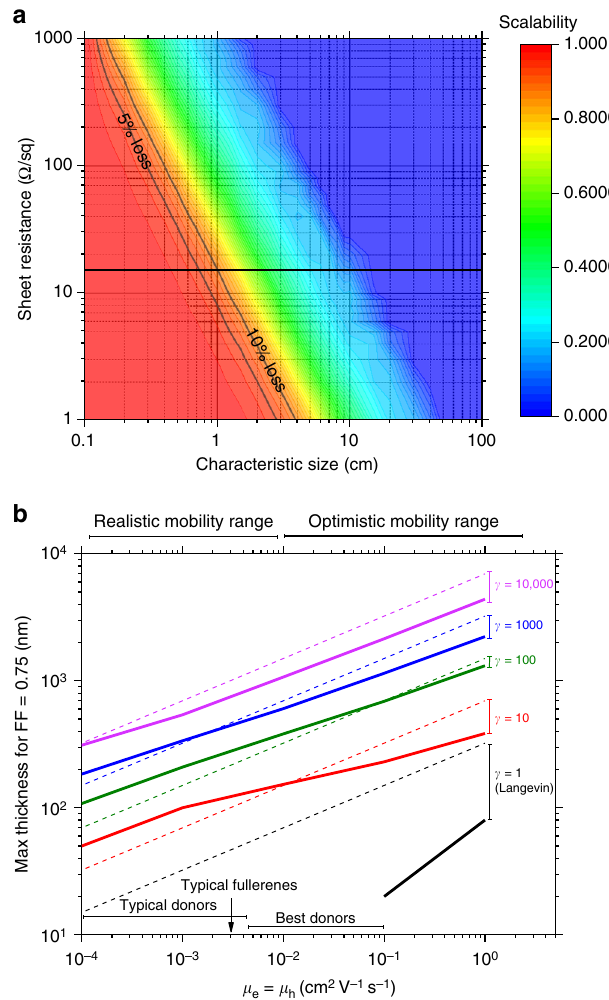
Fig. 2 Scalability and maximum junction thickness versus critical transport parameters. a Scalability as a function of the TCE sheet resistance and the characteristic size (active area, strip width or grid pitch) for a hypothetical solar cell with short circuit current density of 20 mA/cm 2 typical of a high- ef fi ciency OSC or PSC. b Maximum acceptable junction thickness to deliver a 0.75 FF as a function of the carrier mobility μ (for balanced electron and hole mobilities) plotted for different bimolecular recombination reduction factors ( γ ). The numerical calculations were performed for an active layer with a bandgap of 1.6 eV under AM1.5 G illumination. Dashed lines represent predictions from the Neher analytical model 12 and the solid